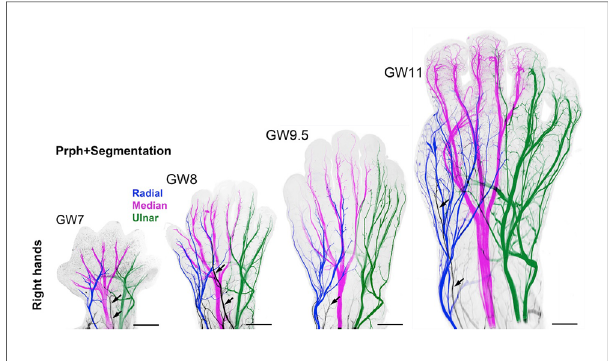
FIGURE 5 3D analysis of the sensory innervation of the developing human hand (67). Time series illustrating the developing innervation of sensory nerves of the right hand from GW7 – GW11, labeled for the neuron- speci fi c intermediate fi lament protein peripherin (Prph). Individual segmentation of the radial (blue), median (magenta), and ulnar (green) nerves are shown. The musculocutaneous nerve (arrows) transiently extends into the hand. Prph, neuron-speci fi c intermediate fi lament protein peripherin; 3D, three-dimensional; GW, gestational week.